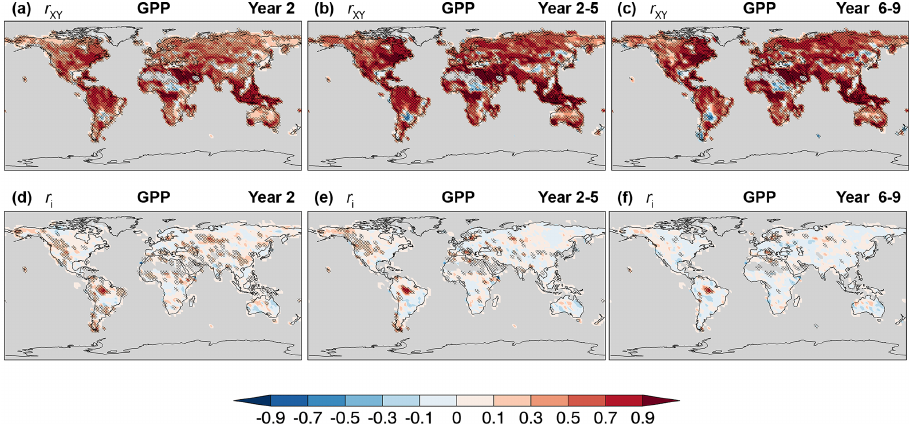
Figure 20. As in Fig. 19 for GPP on